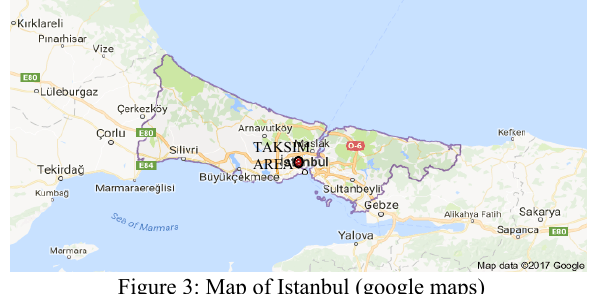
Figure 3: Map of Istanbul (google maps)